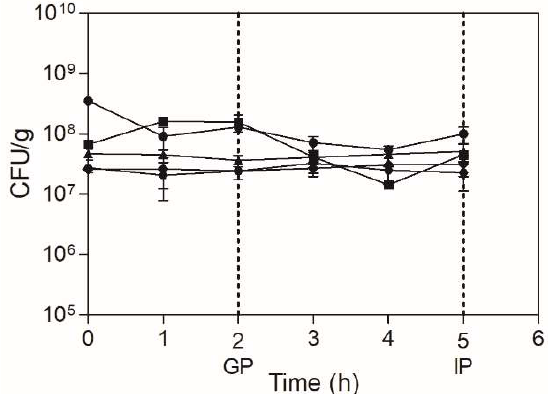
Figure 4. Viability of spray-dried A. muciniphila DSM 22,959 exposed to simulated GIT conditions for 5 h. The assessment was performed at defined timepoints after aerobic, refrigerated storage: 1 (circles); 14 (squares); 28 (triangles); 45 (hexagons); and 60 (diamonds) days. GP = end of the gastric phase; IP = end of the intestinal phase.